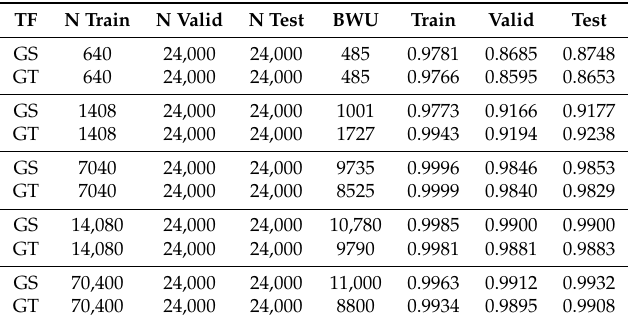
Table notation: TF—Time-frequency representation. N train, N valid and N test—Number of samples in training, validation and testing sets. BWU—Weight update after which the highest performance was achieved on the validation set. Train, valid and test—accuracy on training, validation, and testing